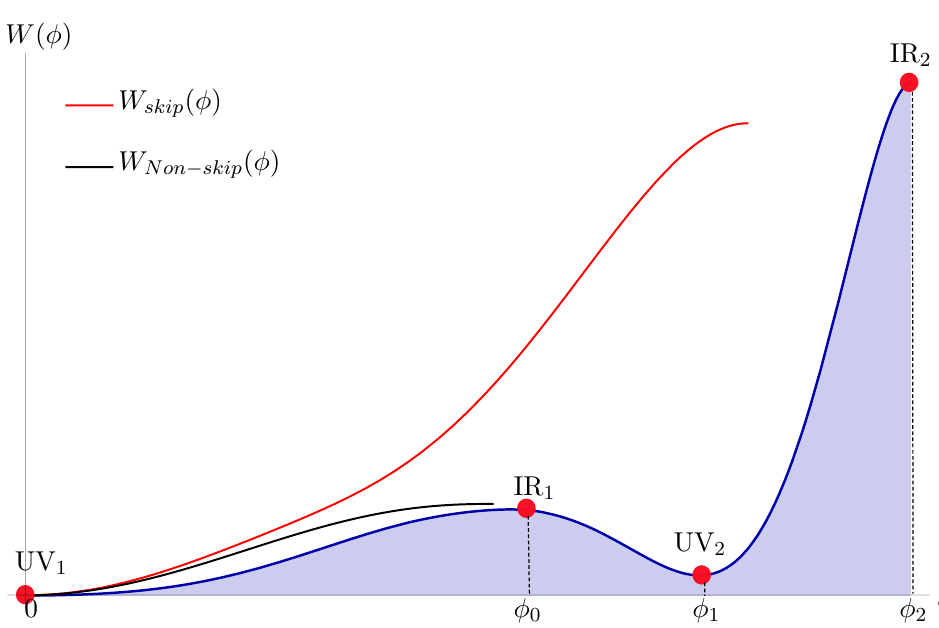
Figure 7 . Finite temperature solutions arising from the potential (3.1) and connecting to UV 1